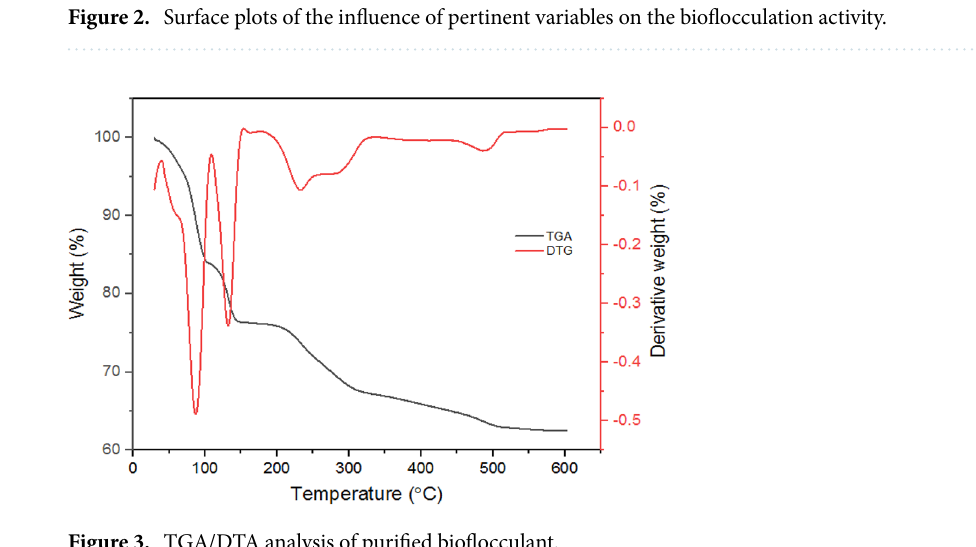
Figure 3. TGA/DTA analysis of purified bioflocculant.